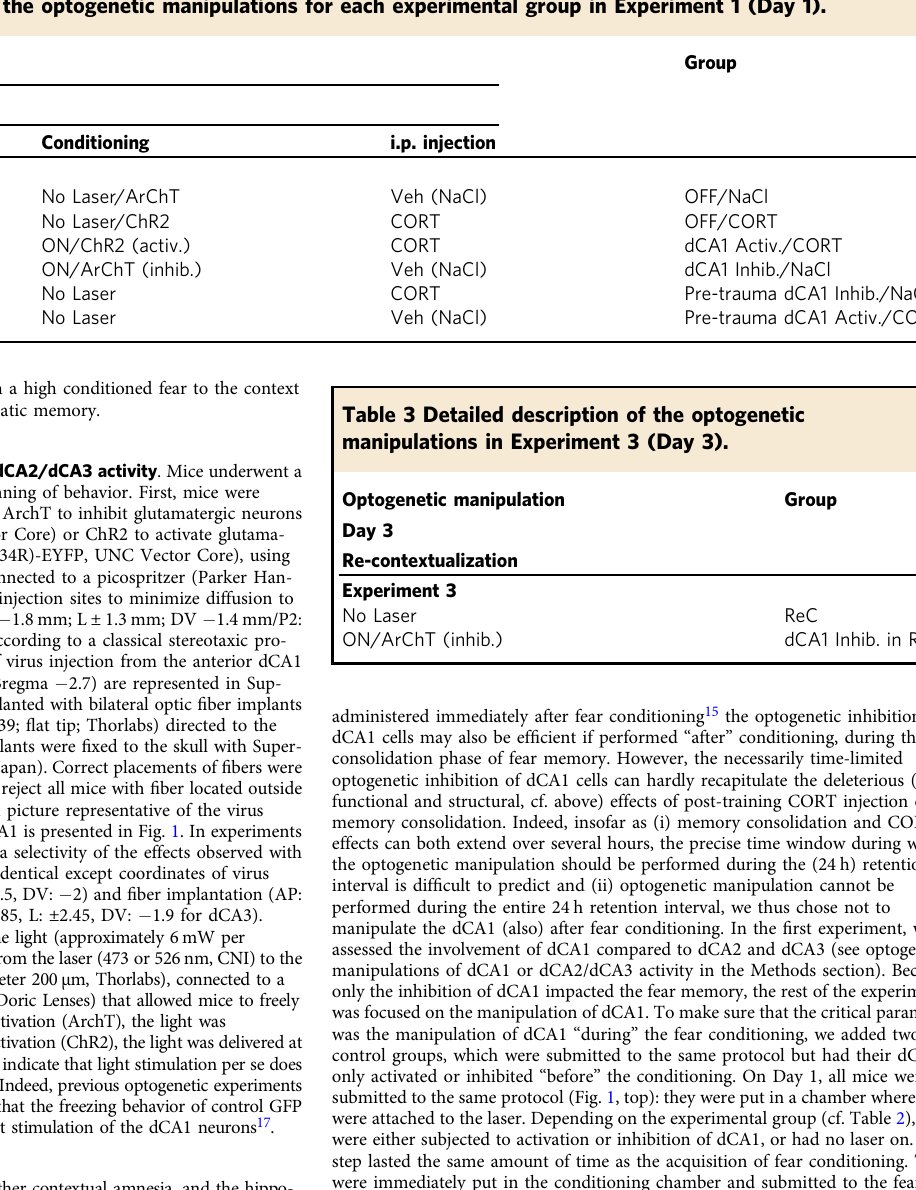
Table 2 Detailed description of the optogenetic manipulations for each experimental group in Experiment 1 (Day 1).